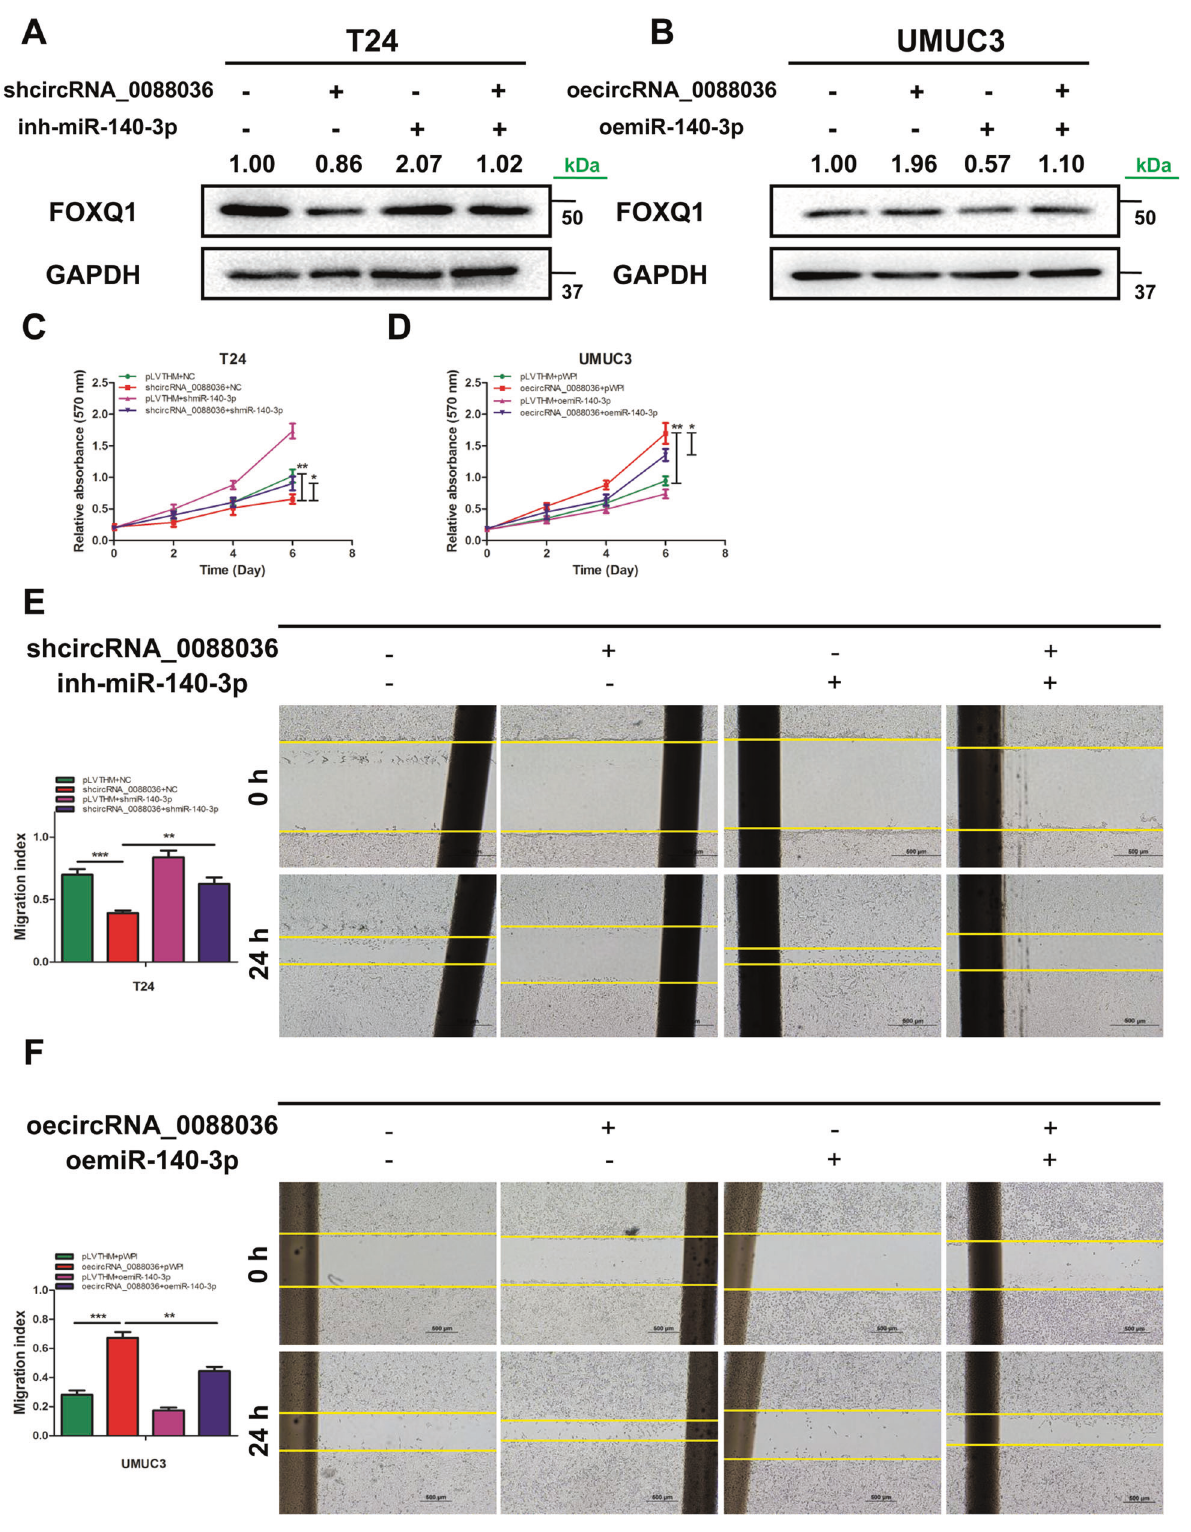
RNA extraction from formalin- fi xed, paraf fi n-embedded (FFPE) blocks The tissue slides were cut into 30 μ M sections from the paraf fi n block using a microtome. Then, they were placed into siliconized tubes, and added 1 mL 100% xylene. After that, the tissue slides were incubated at 50 °C for